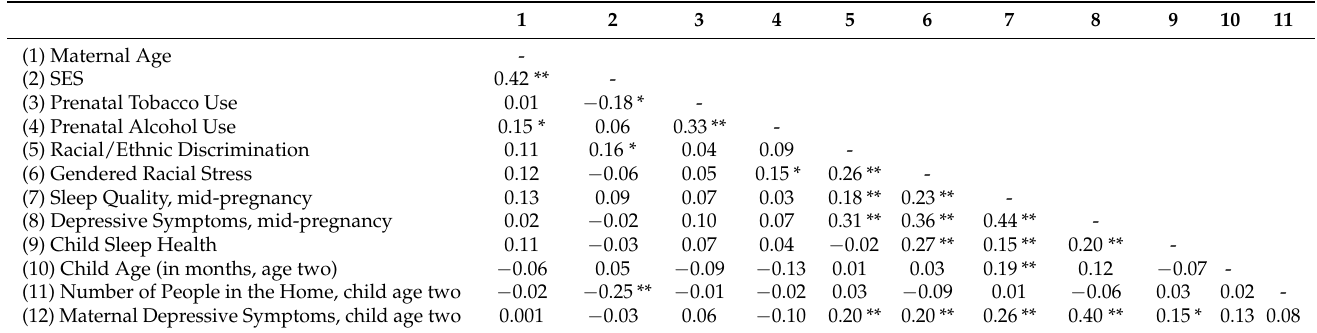
Table 2. Correlations between study variables ( N = 205 for all cells) a .